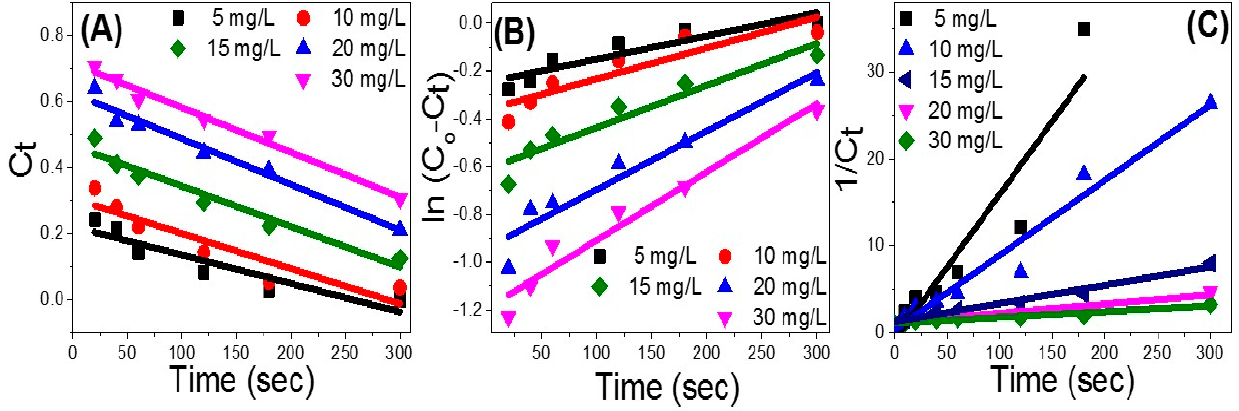
Figure 8. Photodegradation data fitting using ( A ) zero-order ( B ) first-order, and ( C ) second-order kinetic models. Table 2. The zero-, first-, and second-order kinetic parameters using 20 mg Fe 2 O 3 -zeolite photocata- lyst for photodegradation of MB of different concentrations.